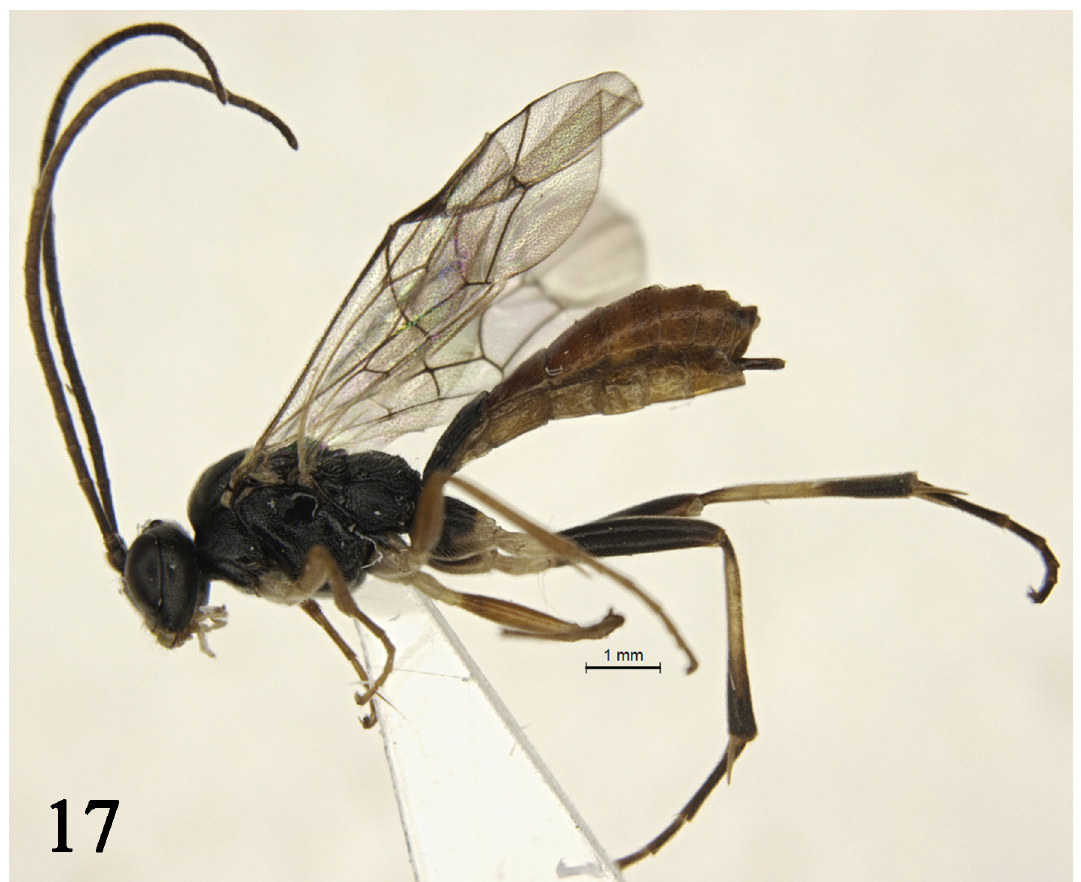
Fig. 17. Campodorus shandongicus Sheng, Sun & Li sp. nov., holotype, ♀, habitus, lateral view